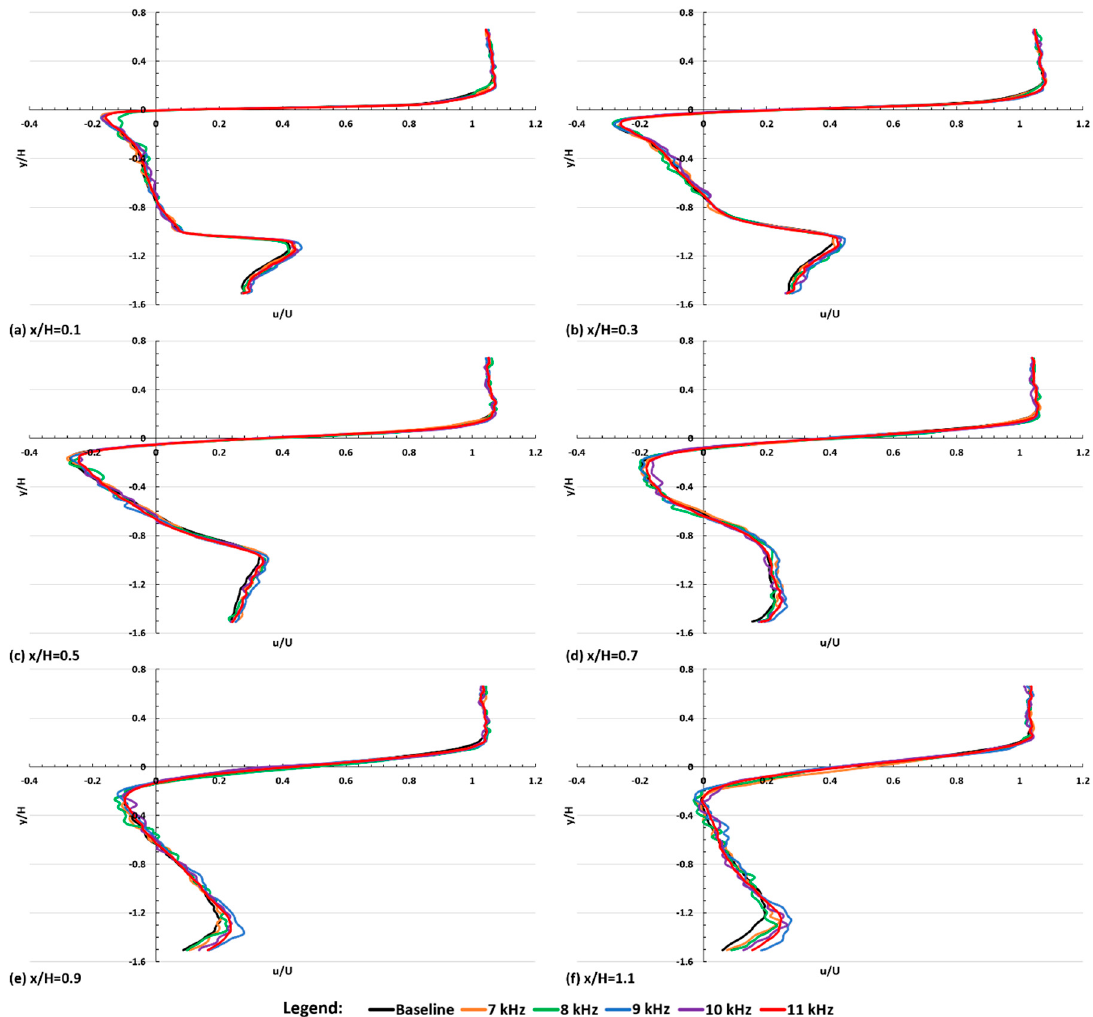
Figure 11. Normalised x-velocity profiles measured at various normalised x-locations along the wake region. x / H = ( a ) 0.1, ( b ) 0.3, ( c ) 0.5, ( d ) 0.7, ( e ) 0.9, and ( f ) 1.1.